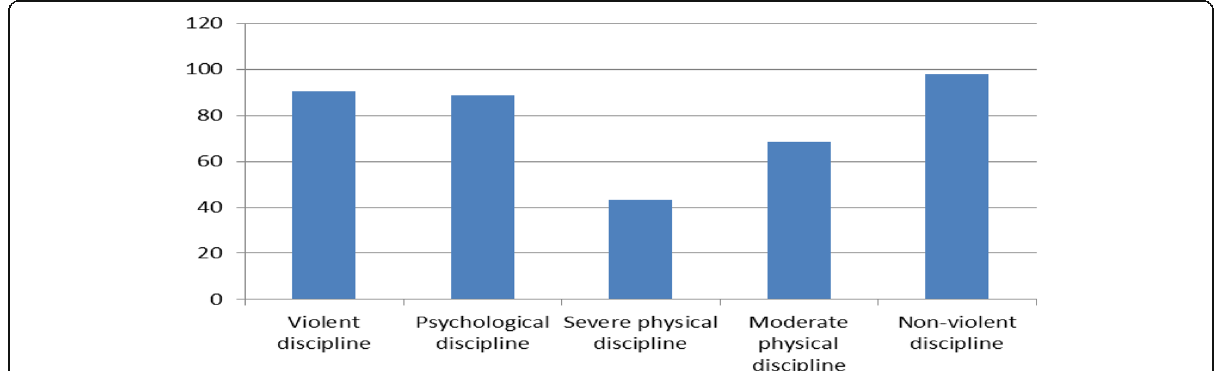
Fig. 2 Distribution of studied children according to the discipline practice reported by their parents during COVID-19 pandemic, Egypt, 2020, using adapted ICAST-P